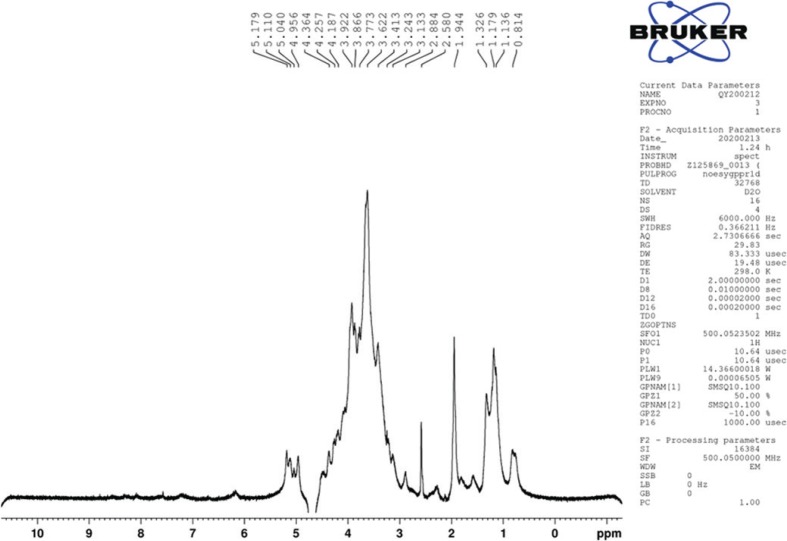
The1H NMR spectrum of EPS-NA3.